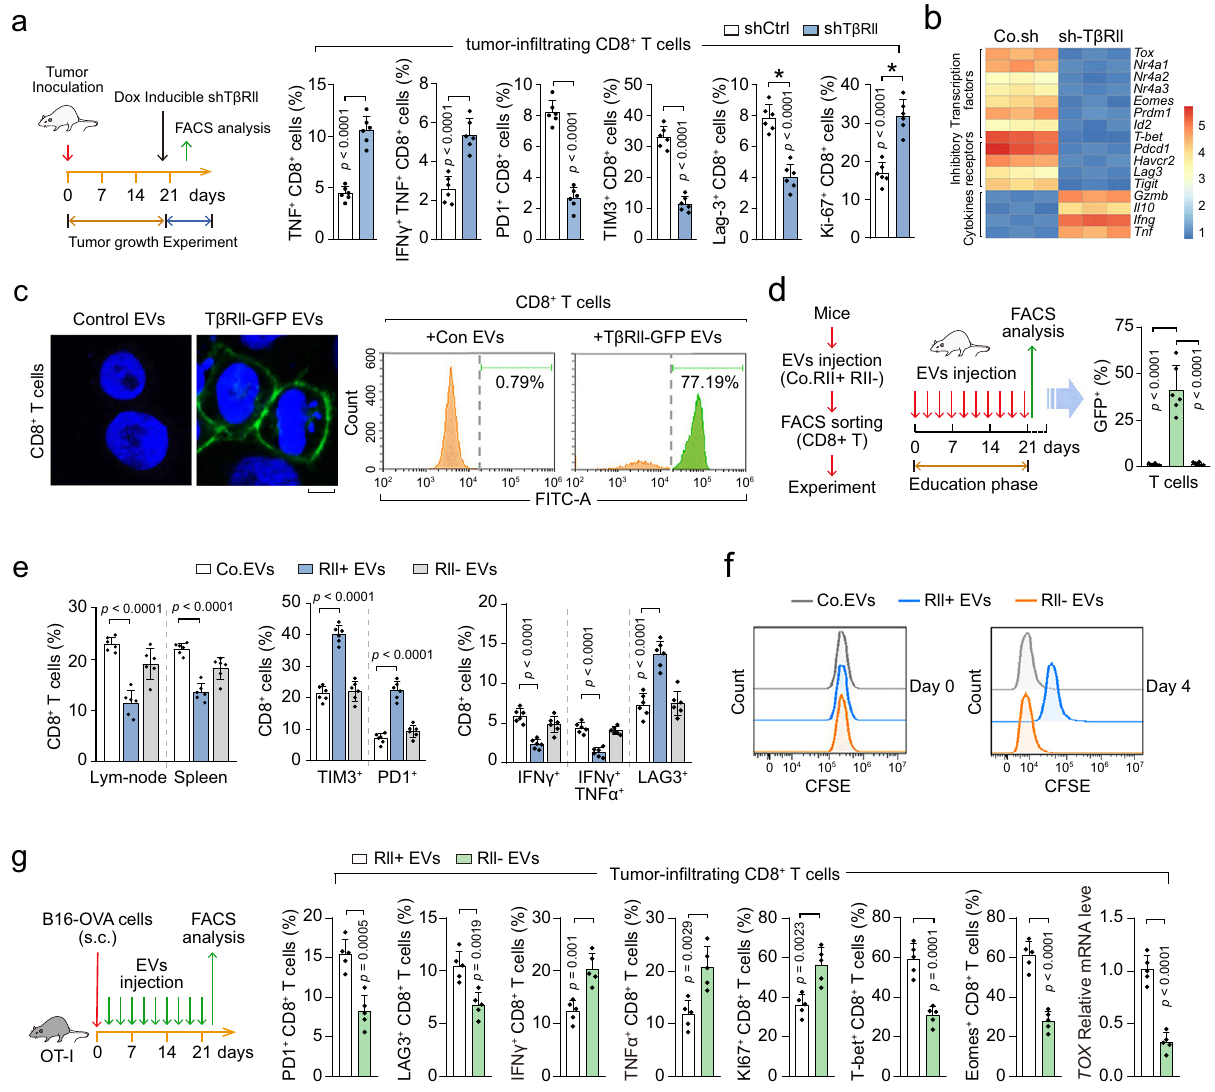
Fig. 7 EV-T β RII mediates the exhaustion of CD8 + T cells by TEVs. a Experimental analysis in vivo: BALB/c mice were nipple injectied with 4T1 cells (2 × 10 5 cells per mouse) expressing control shRNA or doxycycline-inducible shRNA targeting T β RII (shT β RII) and tumors were grown for 3 weeks ( n = 6 mice per group), followed by the administration of doxycycline (Dox) as in Fig. 6a (left panel). Frequency of CD8 + T cells expressing TNF α , IFN γ ,